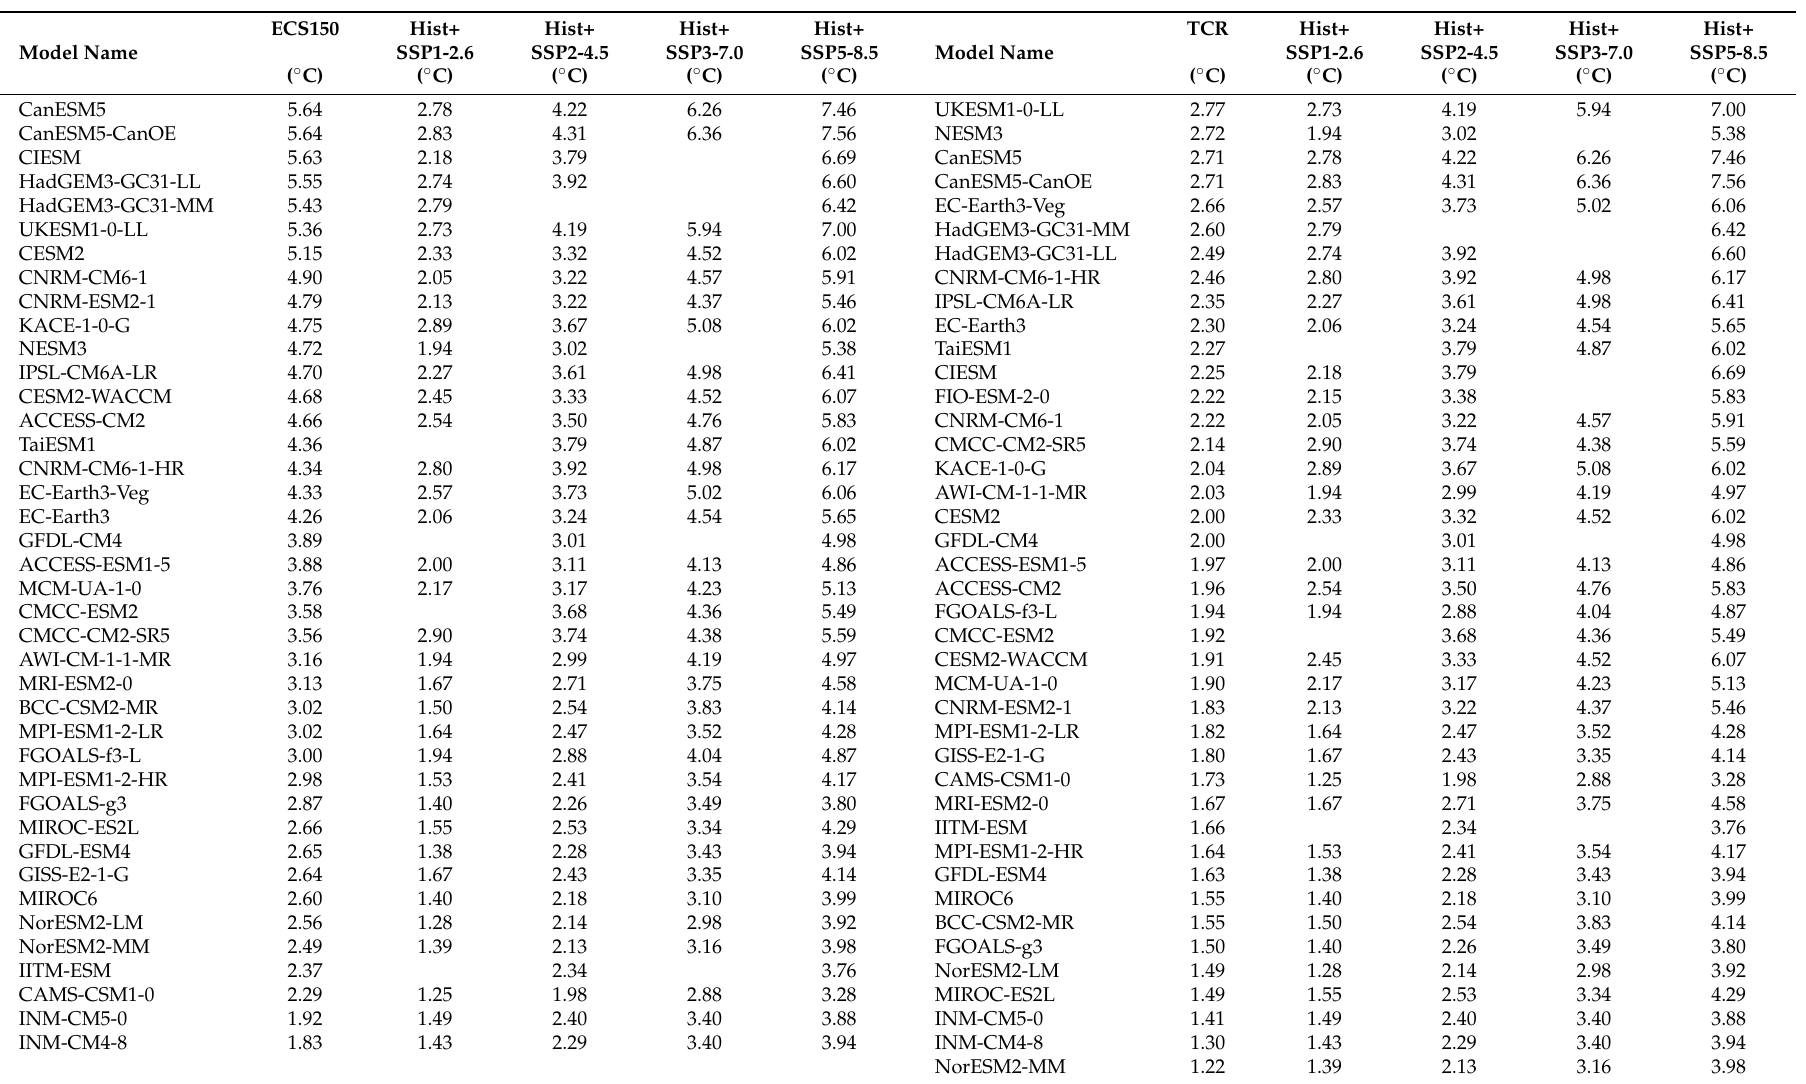
Table A4. Temperature change from 1850–1899 to 2090–2100 for the CMIP6 Global Circulation Models (GCMs). Ranking using ECS-150 and TCR from Hausfather et al.